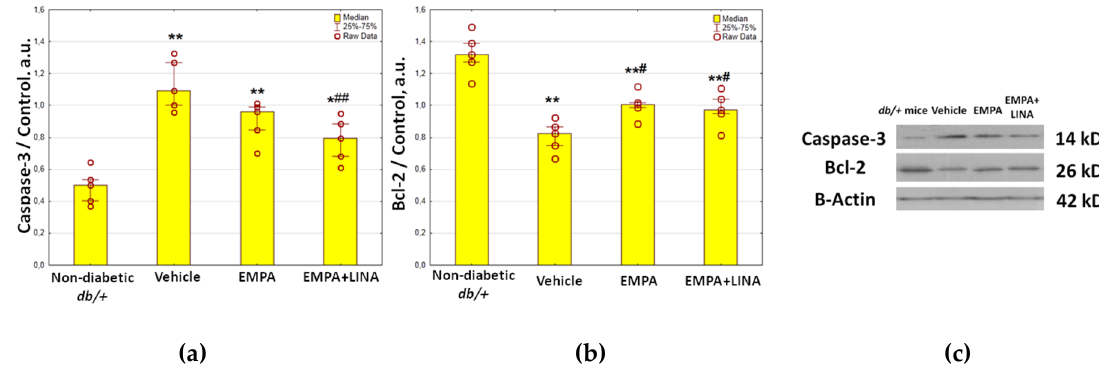
Figure 3. Protein expression of LC3B, an autophagosome marker ( a ), and LAMP-1, a lysosome marker ( b ), in the renal cortex from non-diabetic db/+ mice and diabetic db/db mice treated with vehicle, empagliflozin, or empagliflozin–linagliptin; (c) representative immunoblots of LC3B, LAMP-1 and β- actin as the control. Data are presented as a bar graph (median, lower and upper quartile) with individual data set (dots); a.u., arbitrary unit; ** p < 0.01 vs. non-diabetic db/+ mice; # p < 0.05, ## p < 0.01 vs. vehicle-treated db/db mice (Mann–Whitney U-test).